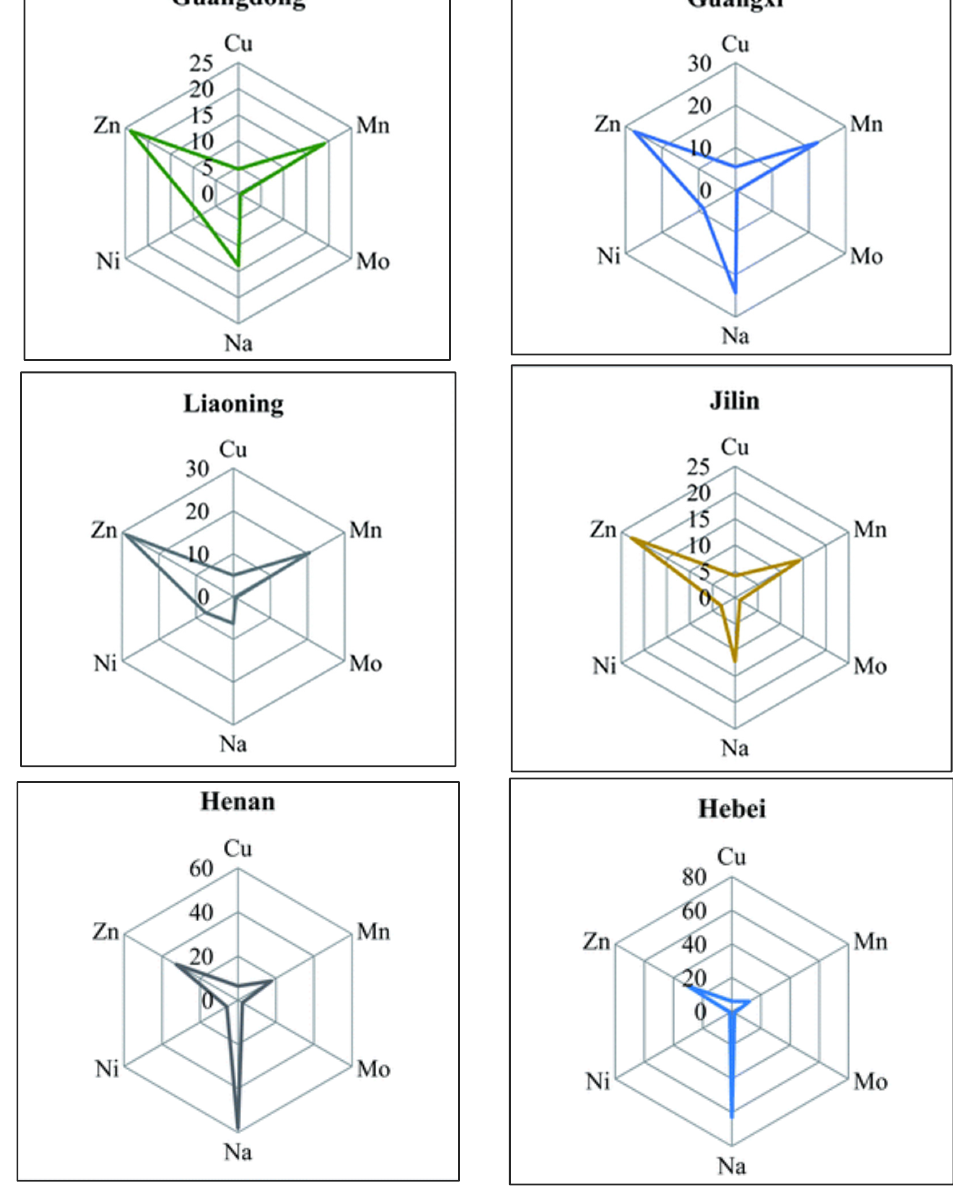
Figure 9. Radar plots of the elements Cu, Zn, Ni, Na, Mo and Mn in six different regions of China. Figure is reprinted with permission from Ref. [195].